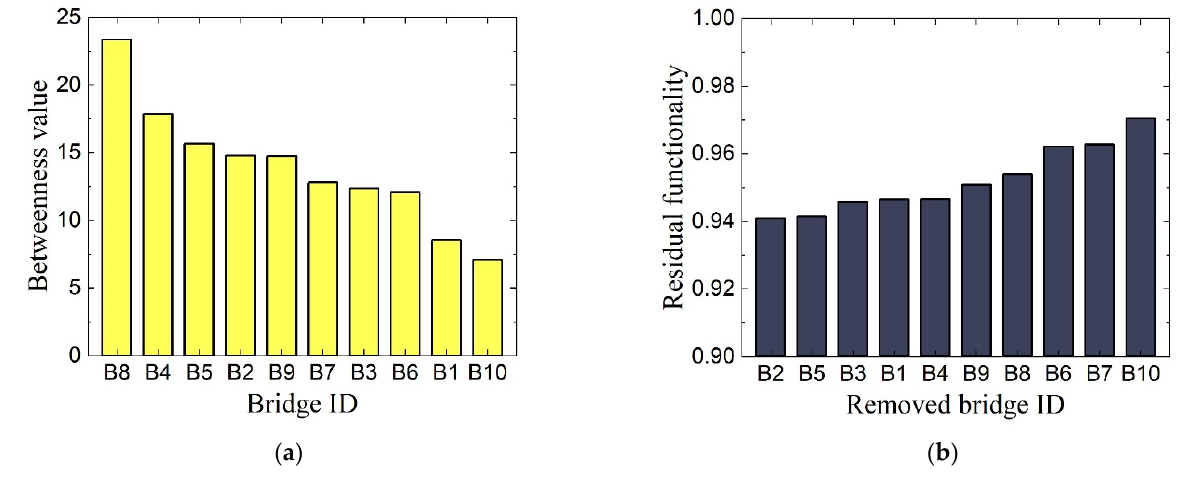
Figure 3. BC-based and RE-based importance ranking results. ( a ) Betweenness value of each bridge; ( b ) Residual functionality of removing each bridge.